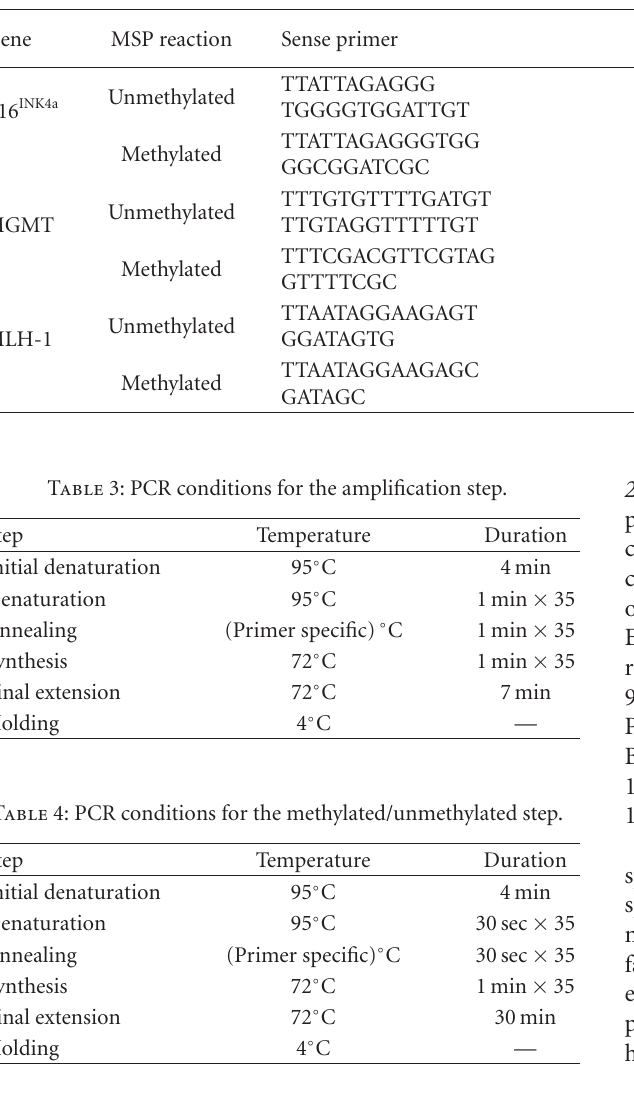
Table 2: Primers used in the analysis of methylation at the amplified CpG islands of bisulfite treated DNA by PCR including their sequences and annealing temperature.